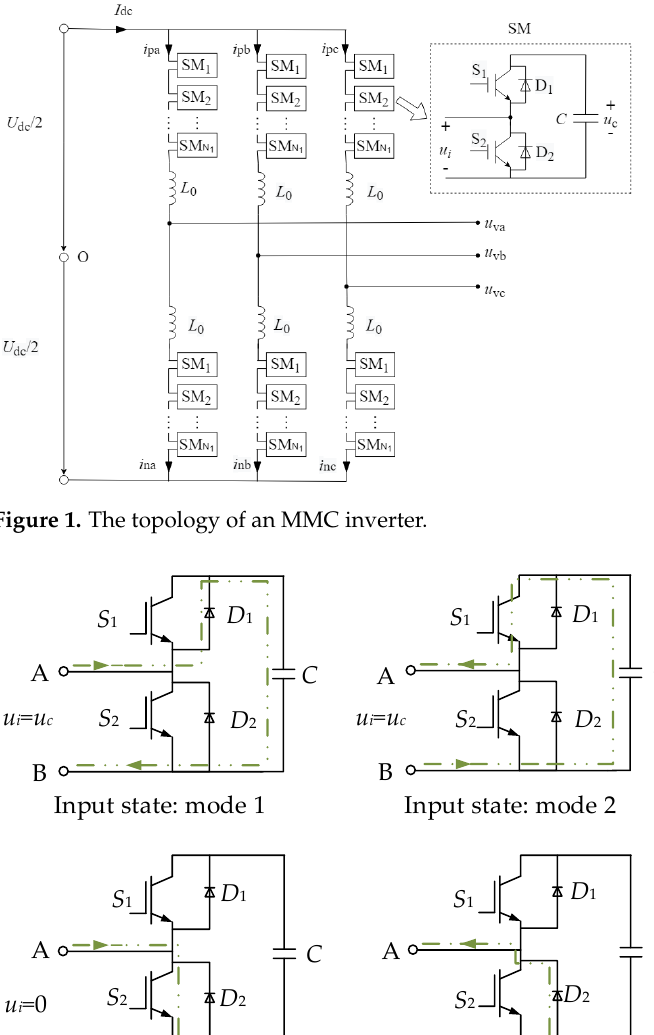
Figure 1. The topology of an MMC inverter.